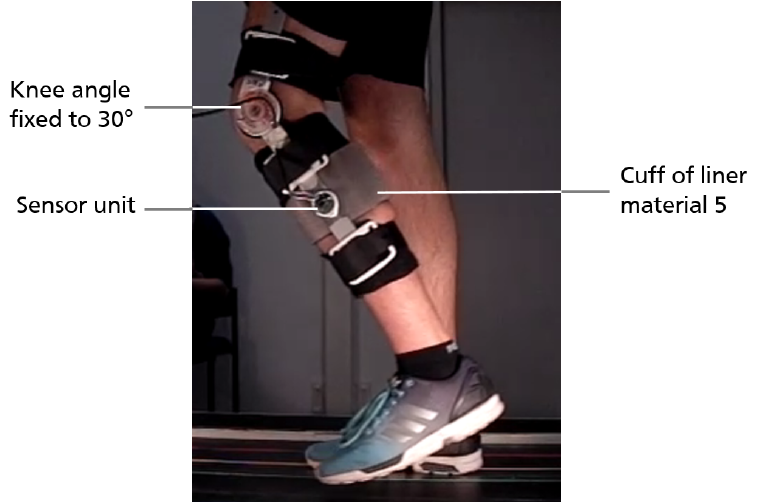
Figure 10. Measurement setup for treadmill gait: the sensor unit is attached to the lateral splint of the orthosis, measuring the relative movement between shank (cuff of liner material 5) and